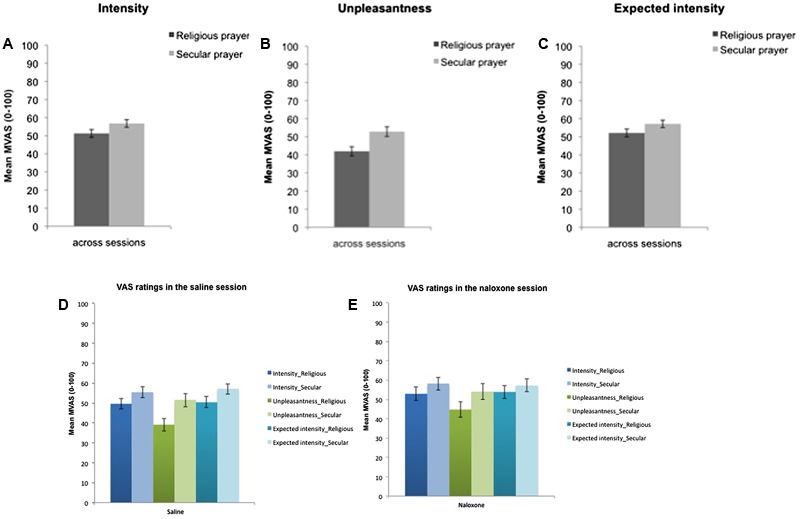
Mean ratings of (A) pain intensity, (B) pain unpleasantness, and (C) expected pain intensity across naloxone and saline sessions and mean ratings of these variables separately in saline (D) and naloxone (E) sessions. Error bars indicate mean standard error.